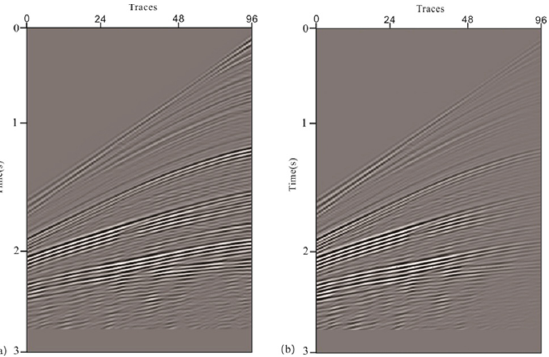
Figure 1. ( a ) The original single-shot records from the Marmousi model and ( b ) the results from the modulation of offsets.